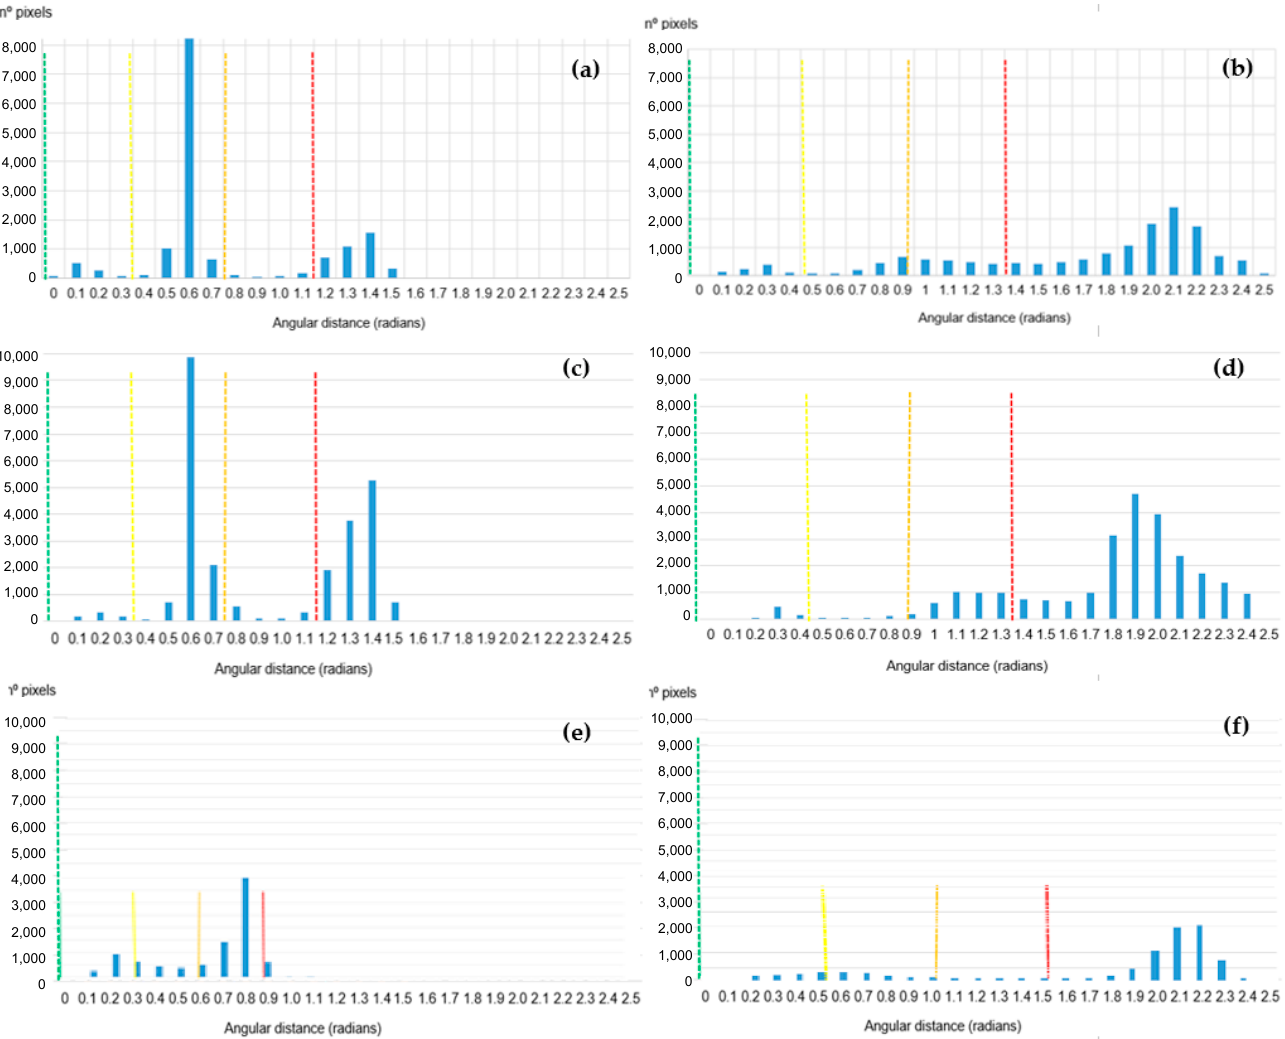
Figure 4. Histograms of angular distances in radians in 2012 in the study sites for NDVI (left) and SASI (right): Ebro Delta ( a , b ), Albufera National Park ( c , d ) and Orellana ( e , f ).